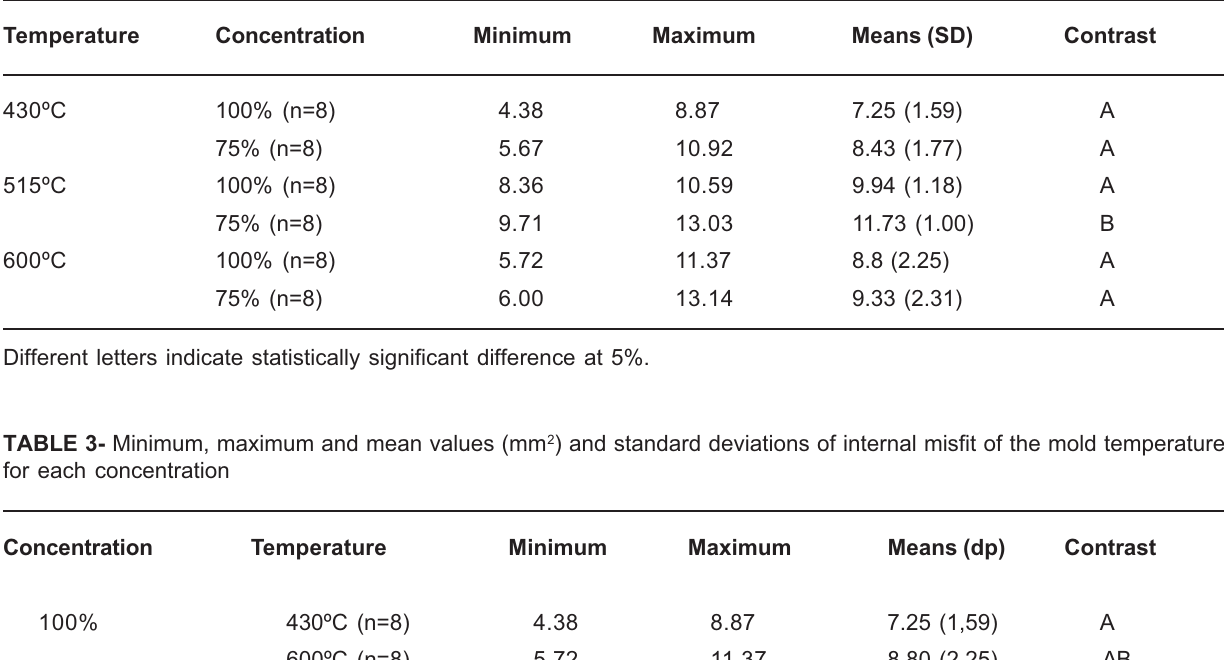
TABLE 2- Minimum, maximum and mean values (mm 2 ) and standard deviations of internal misfit of the concentrations for each mold temperature